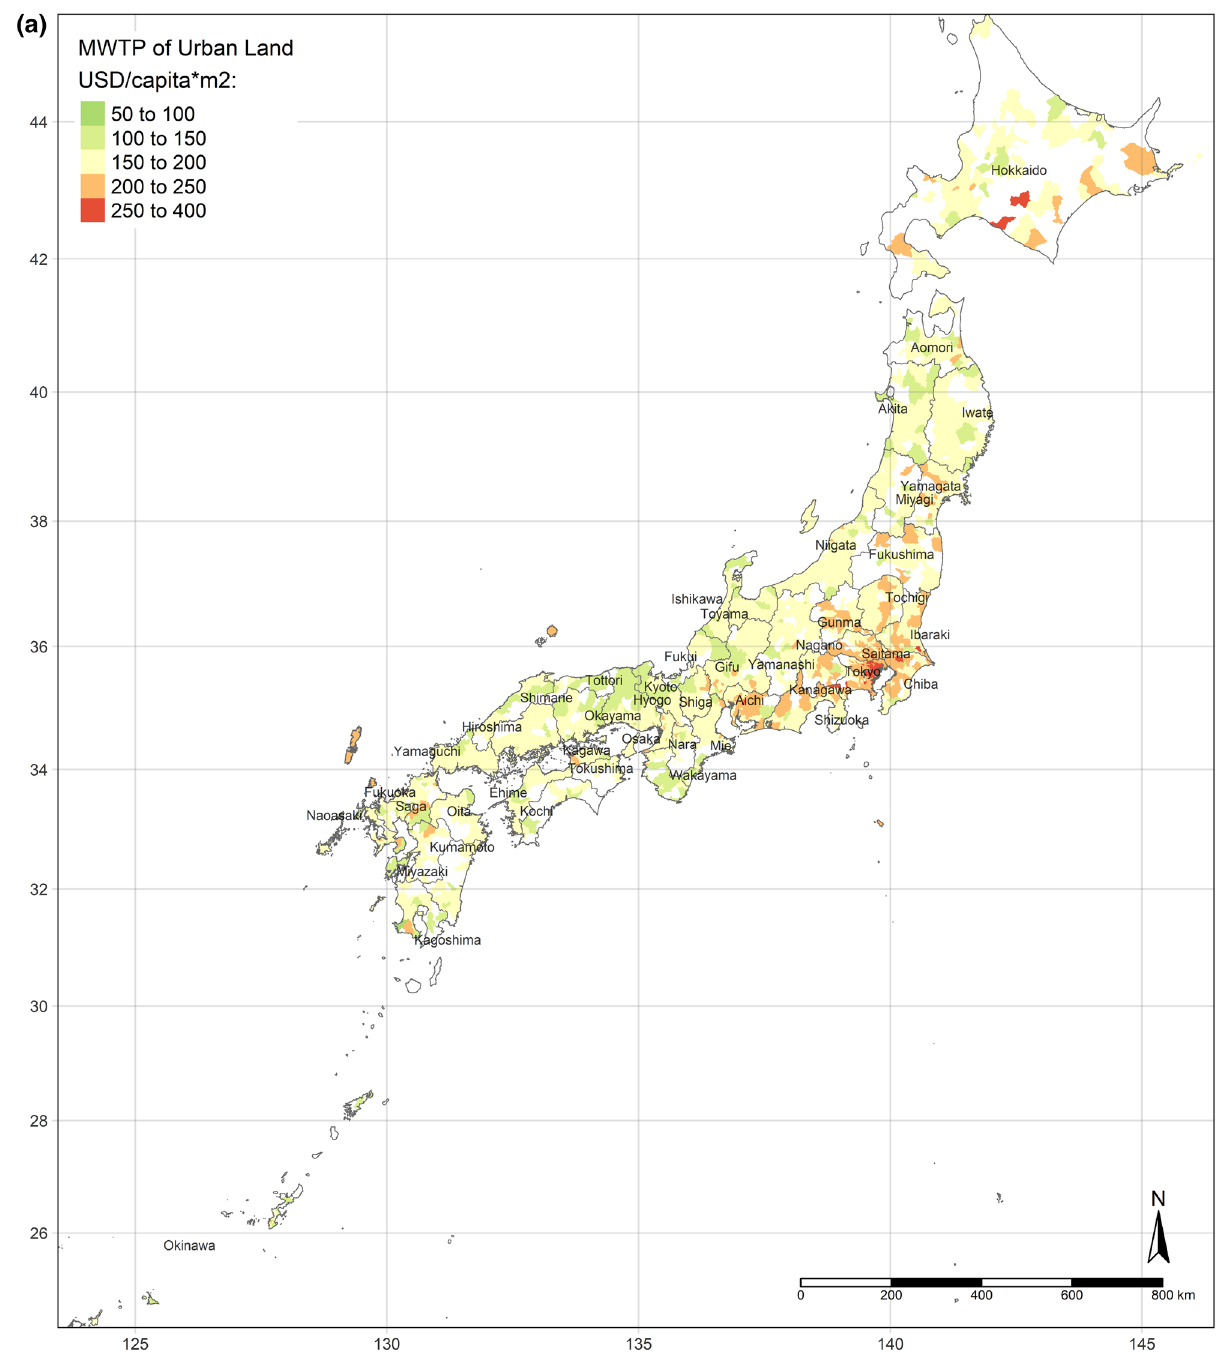
Figure 4. ( a ) MWTP of urban land. ( b ) MWTP of water. ( c ) MWTP of bare land. (Figure a, b, c is created by R 4.0.4, https:// cran.r- proje ct. org/ bin/ windo ws/ base/ old/4.